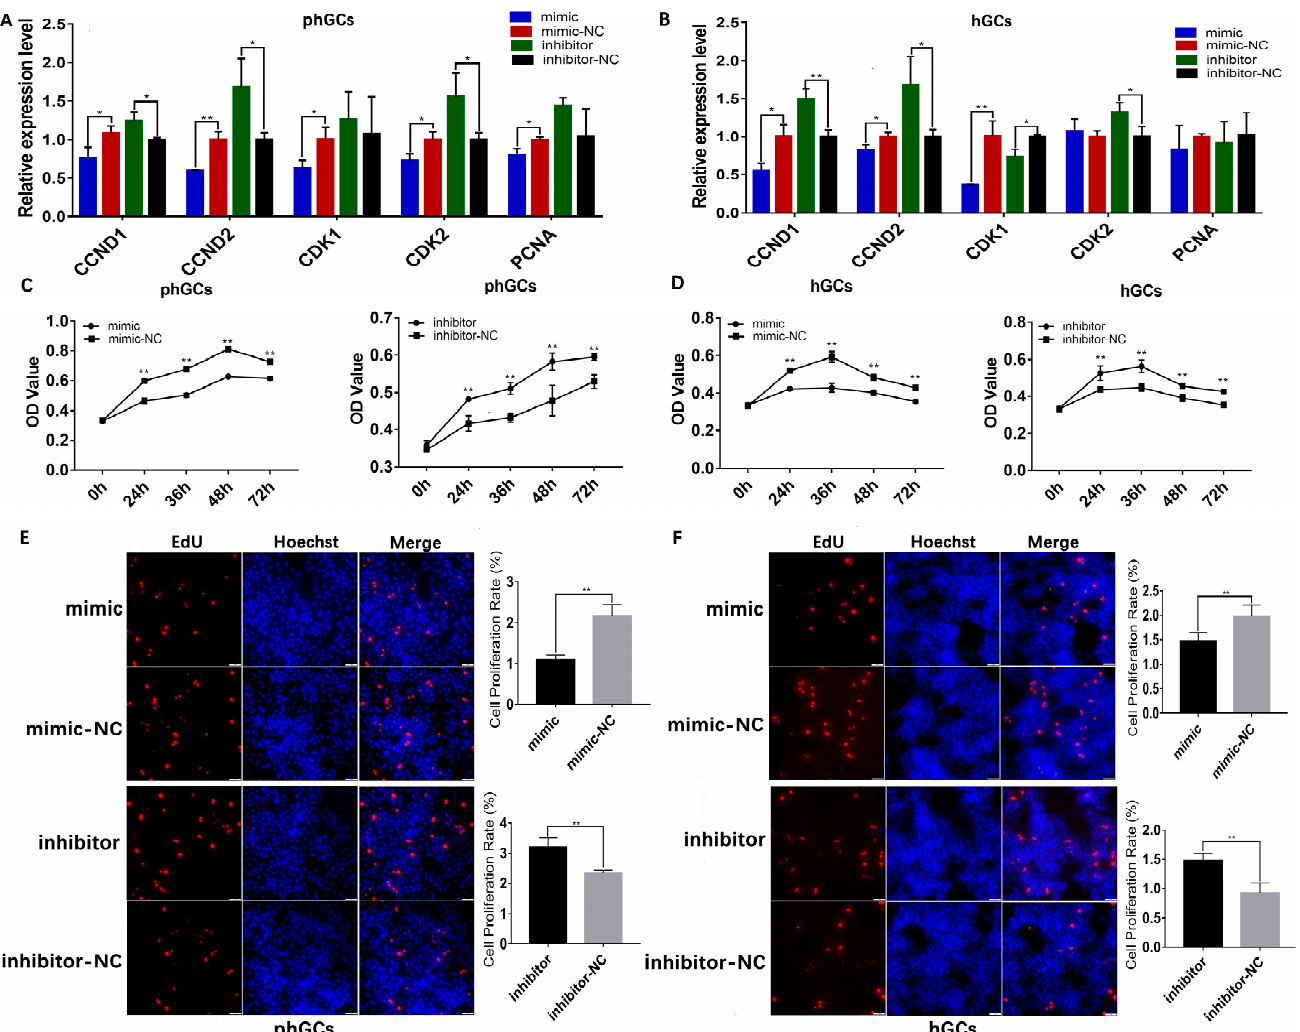
Figure 2. Effect of miR-202-5p overexpression/interference on the proliferation of phGCs and hGCs. Relative expression of proliferation-related genes in phGCs ( A ) and hGCs ( B ) (n = 3); the cell activity of phGCs ( C ) and hGCs ( D ) detected by CCK8 assay (n = 6); the changes in the proliferation rate of phGCs ( E ) and hGCs ( F ) detected by EdU staining (n = 3). Data are means ± SD of technical replicates. “**” indicated a very significant difference among different groups ( p < 0.01), “*” indicated a significant difference among different groups ( p < 0.05).